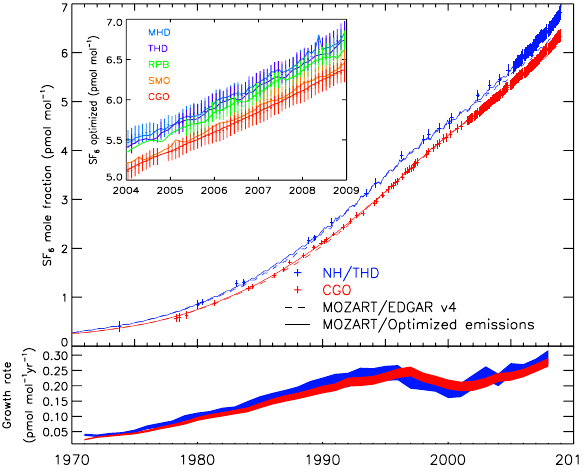
Fig. 1. AGAGE archived air and in situ measurements at Cape Grim, Tasmania (red) and NH sites (mostly Trinidad Head and La Jolla, CA, blue). The dashed lines show the atmospheric mole frac- tion predicted by MOZART using EDGAR v4 emissions (extrap- olated for 2006–2008), and the solid lines show the mole fraction computed using the optimally-estimated emissions. Error bars on the measurements include sampling and modeling uncertainty, as shown in Eq. (1). The inlay in the upper panel shows the measured mole fractions at the five background AGAGE sites used in the global inversion and modeled mole fractions using the optimally- estimated emissions. The lower panel shows the optimized growth rate at Cape Grim and the NH sites, with the line thickness denoting the 1- σ